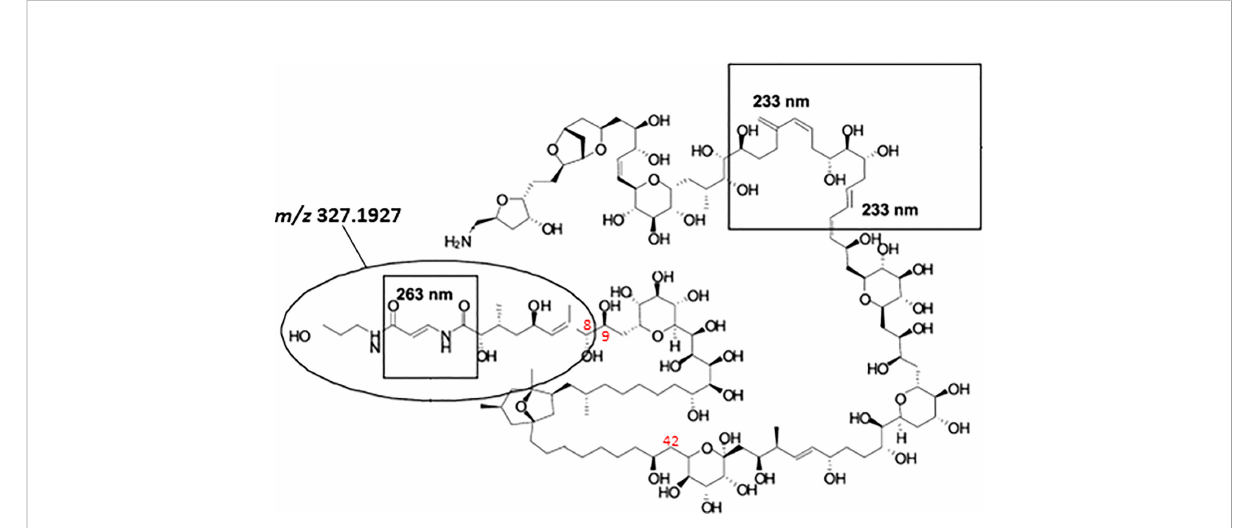
FIGURE 7 Structure of PLTX molecule. The boxes show double bonds responsible of characteristic UV absorption pro fi le. The circle shows the fragment ion at m/z 327.1927 attributed to the cleavage between carbons 8 and 9. The carbon 42 is also numbered. This carbon is bonded to one hydrogen atom or one hydroxyl group in PLTX and 42-OH-PLTX molecules respectively.